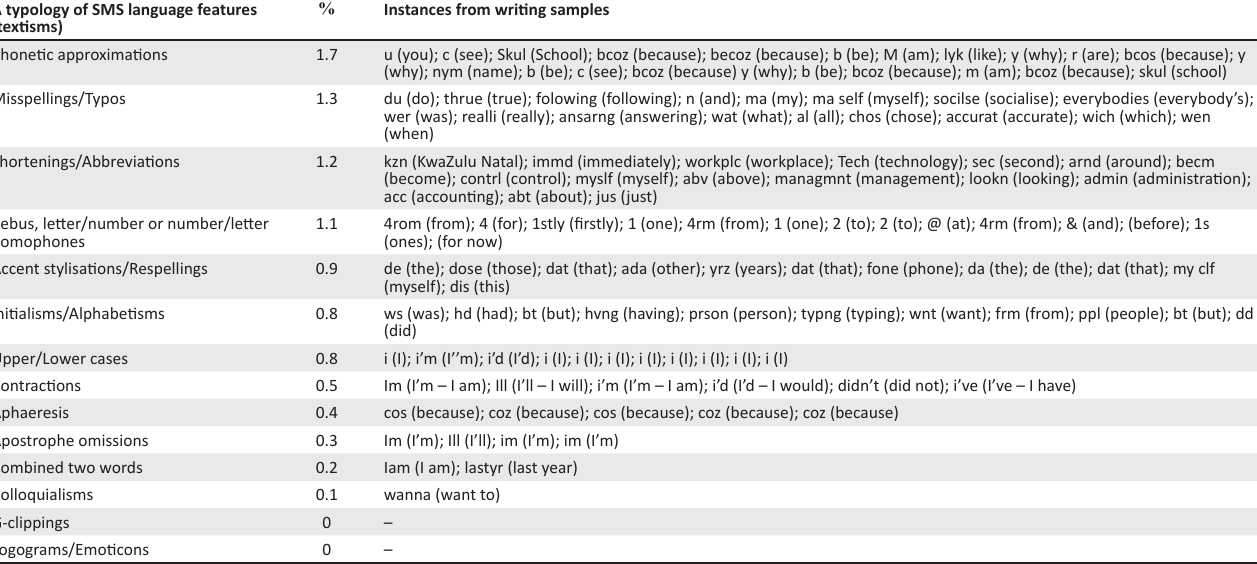
TABLE 4: A typology of SMS language features and corresponding examples of such features in participants’ writing samples. A typology of SMS language features